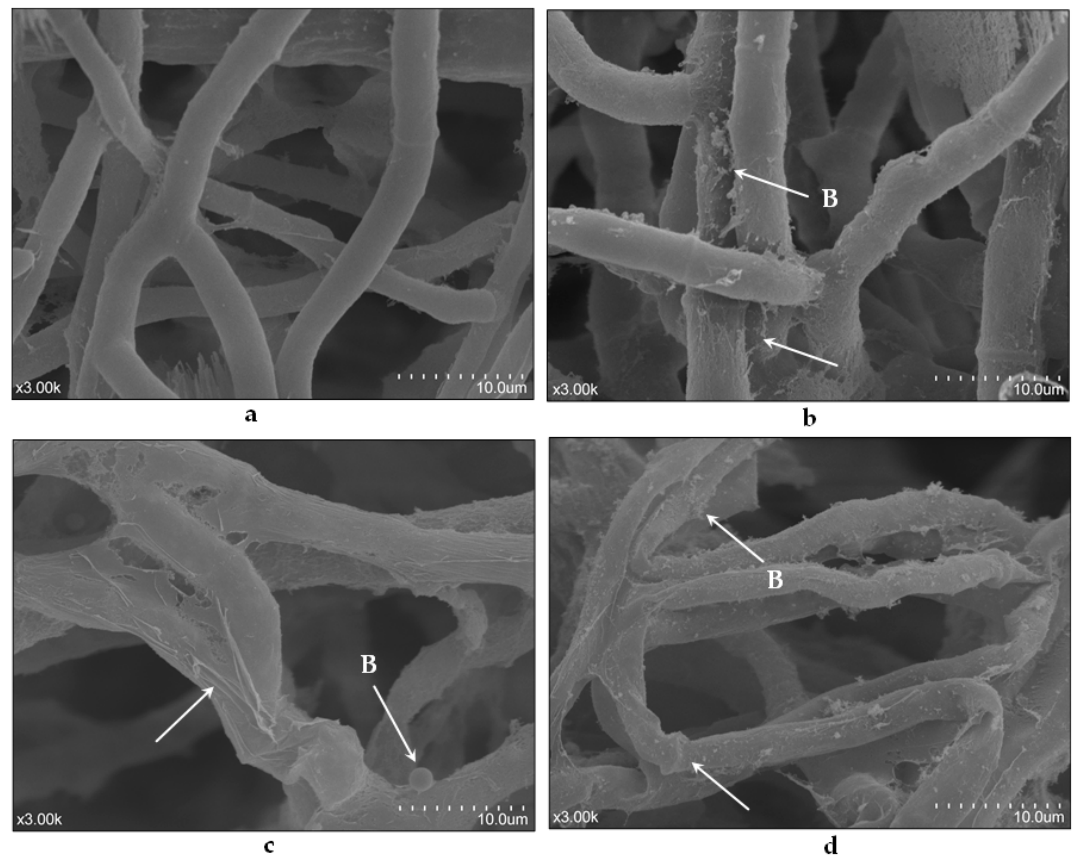
Figure 1. Scanning electron microscopy (SEM) images of Botrytis cinerea hyphae exposed to control ( a ), Cymbopogon citratus ( Cc , b ), Thymus vulgraris ( Tv , c ), and Origanum heracleoticum ( Oh , d ) essential oil. Bar = 10.0 μ m. B, Belbs.